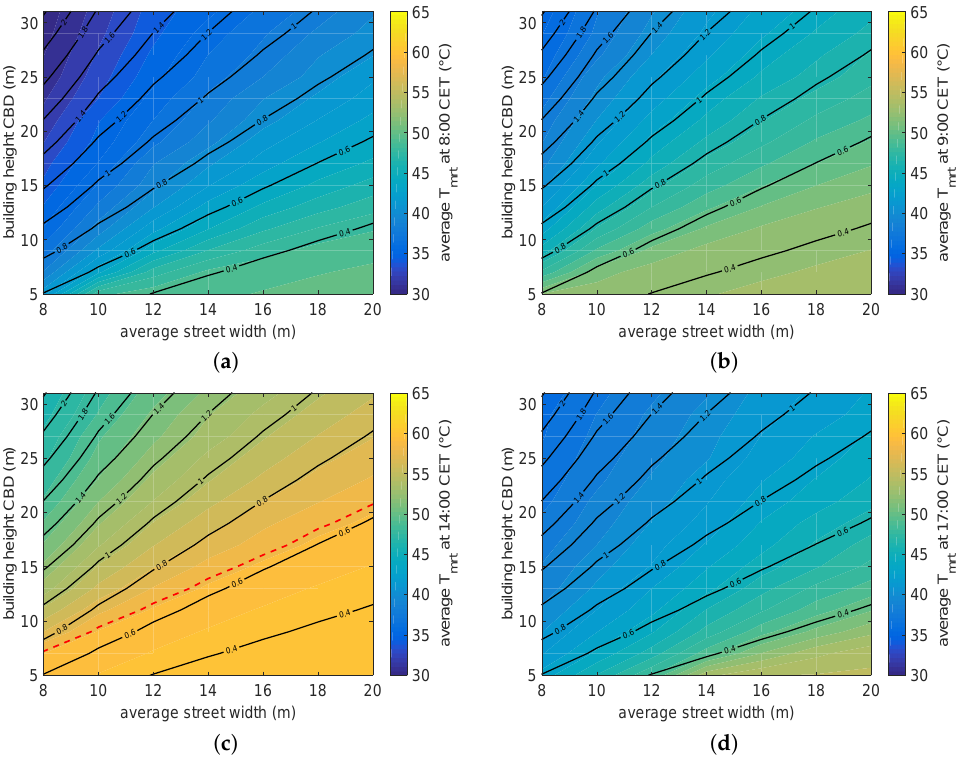
Figure 9. Area averaged T mrt at: ( a ) 8:00 CET; ( b ) 9:00 CET; ( c ) 14:00 CET; and ( d ) 17:00 CET for different street widths W and building heights in the CBD H CBD . Black contour lines indicate the aspect ratio H / W averaged over the whole city while the red dashed line indicates T thr (i.e., 58.8 ◦ C). Albedo of walls, A 0 W , and streets, A 0 S , are set to 0.15.